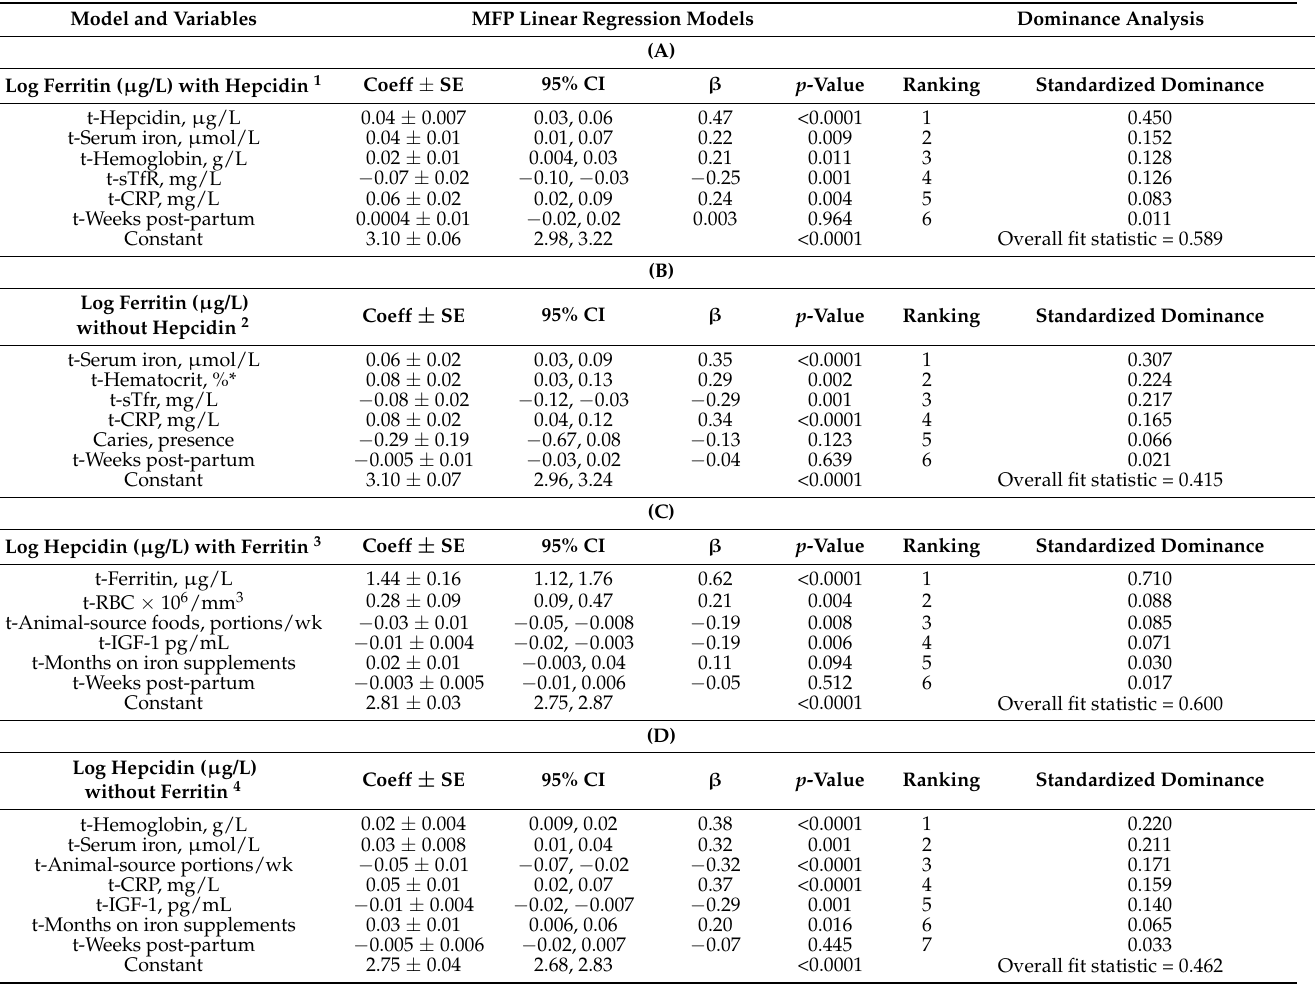
Table 5. MFP linear regression models for (A) ferritin including hepcidin, (B), ferritin excluding hepcidin, (C) hepcidin including ferritin, and (D) hepcidin excluding ferritin, with dominance analysis indicating ranking of